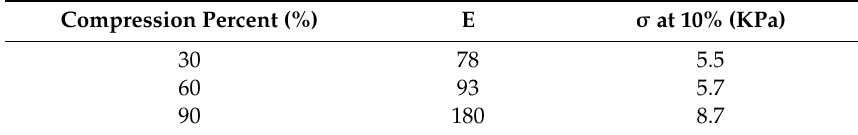
Table 2. Mechanical properties of the samples compressed at various percentages of their original length. Compression Percent (%)